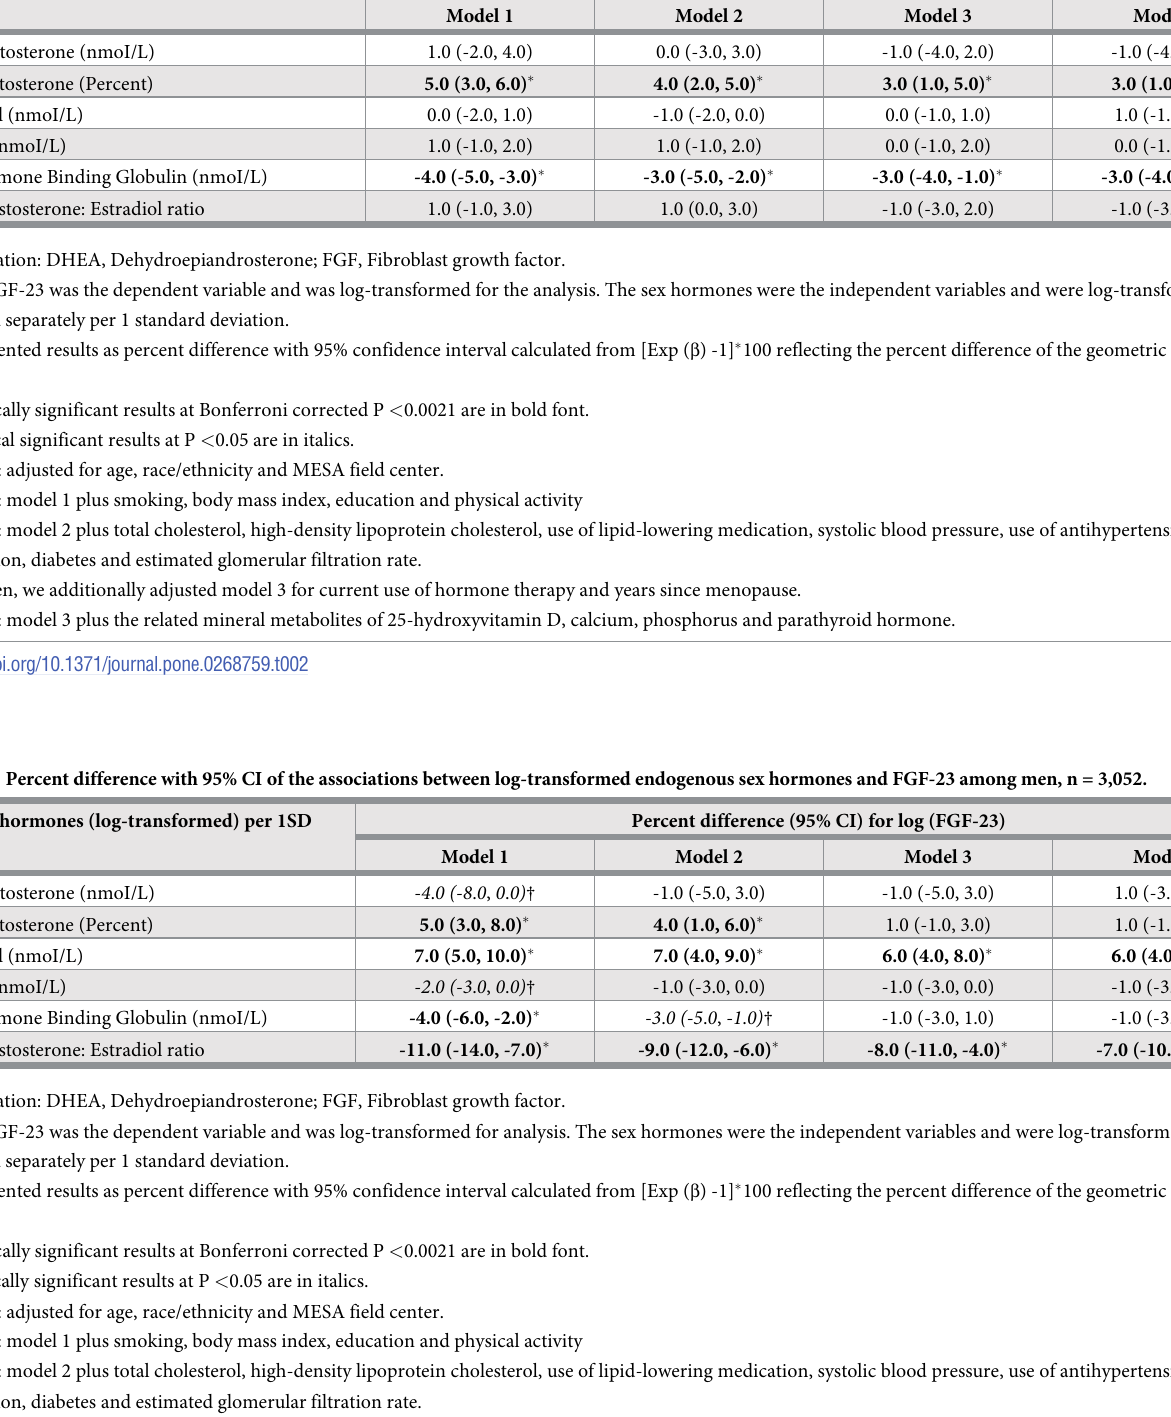
Table 2. Percent difference with 95% CI of the associations between log-transformed endogenous sex hormones and FGF-23 among women, n = 2,868. Sex hormones (log-transformed) per 1SD